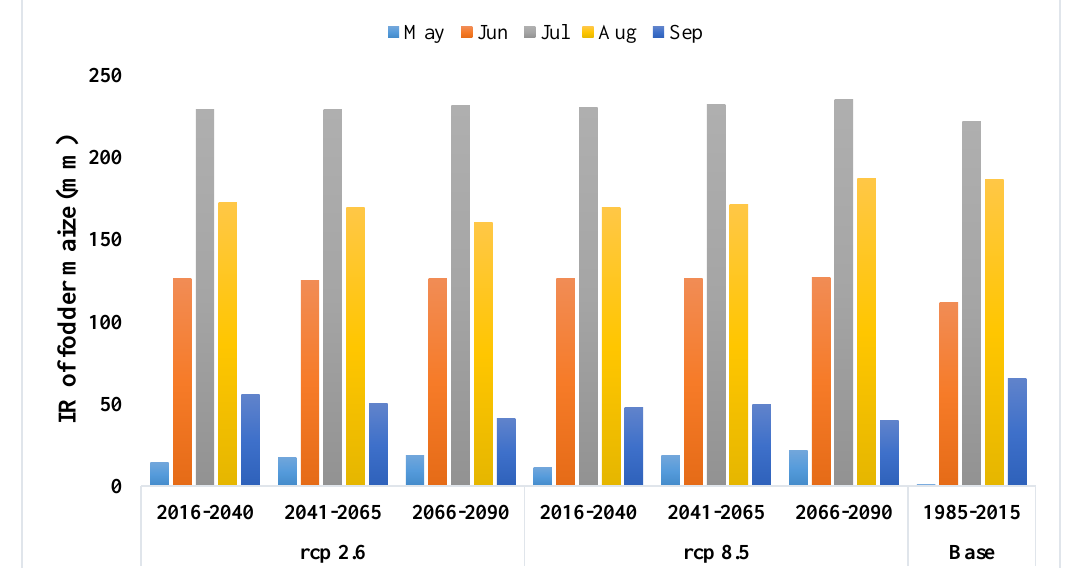
Figure 6. Comparison of the irrigation water requirement (IR) of fodder maize under scenarios rcp2.6 and